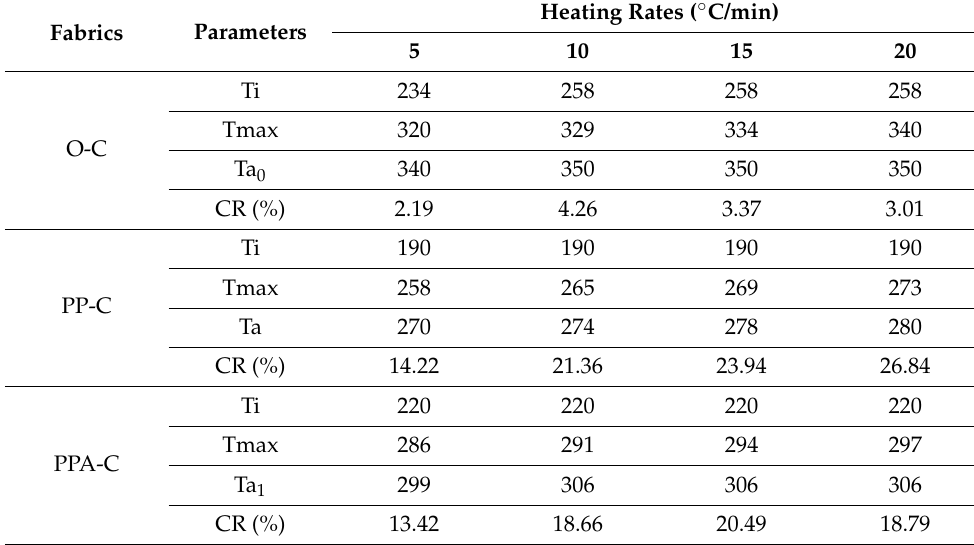
Table 3. TG parameters of flame-retardant fabric at different heating